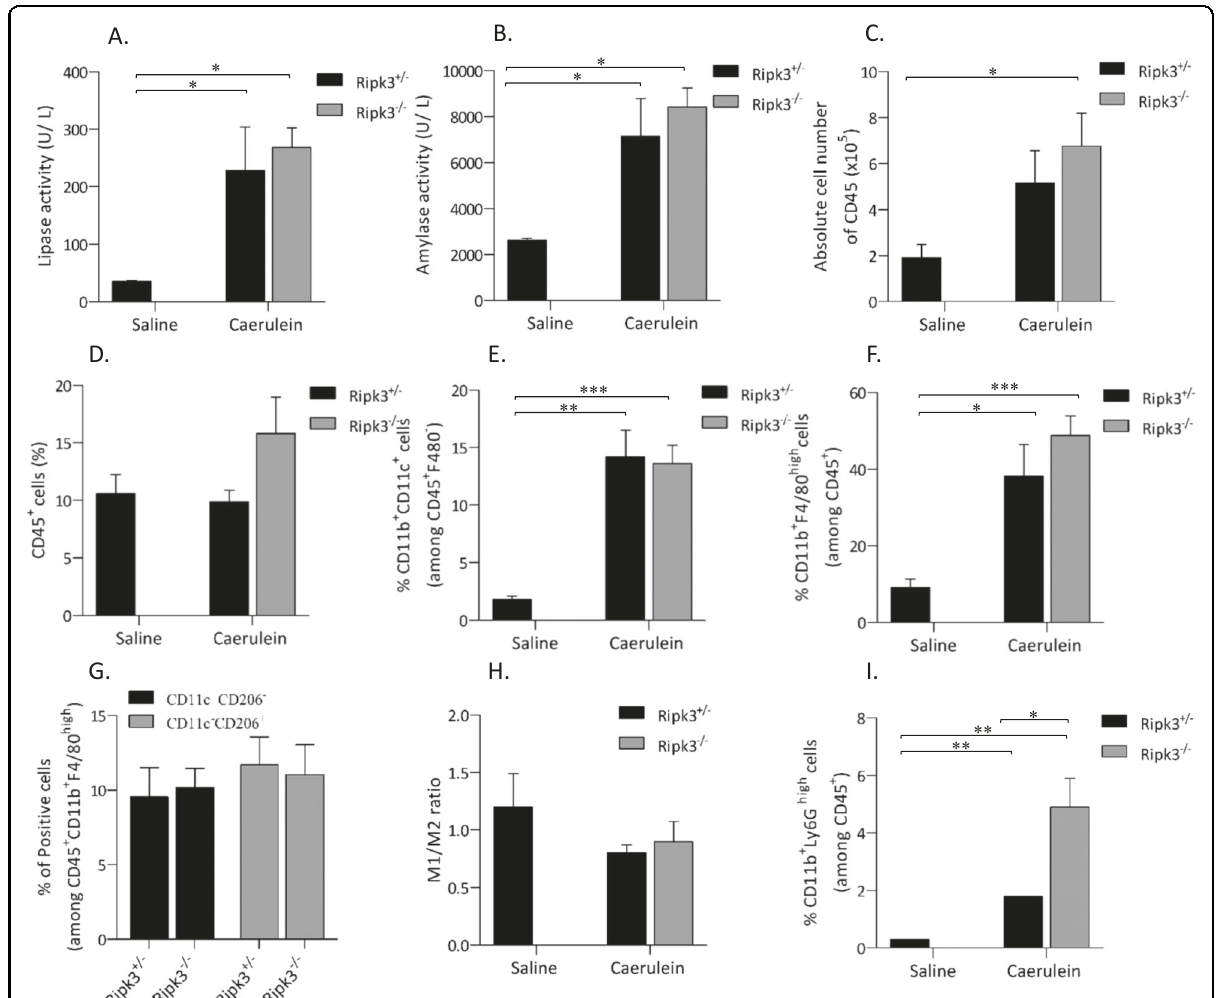
Fig. 6 The severity of AP in Ripk3 − / − mice was associated with neutrophil in fi ltration. Lipase ( A ) and amylase activity ( B ) were determined in serum collected at 12 h after the last injection of either PBS or caerulein. C Absolute CD45 + cell counts in freshly isolated pancreatic tissues from each group were determined by an automated cell counter. Flow cytometry analysis was performed to identify in fl ammatory immune cells in pancreatic tissue. Bar plots showing the percentage of CD45 + cells ( D ), the percentage of CD45 + F4/80 − CD11b + CD11c + dendritic cells ( E ), the percentage of CD45 + CD11b + F4/80 high macrophages ( F ), the percentages of CD11c + CD206 - M1-like macrophages and CD11c − CD206 + M2-like macrophages ( G ), the ratio of M1/M2 macrophages ( H ), and the percentage of CD45 + CD11b + Ly6G high neutrophils ( I ). The data are presented as the means ± SEMs. * P < 0.05, ** P < 0.01, and *** P < 0.001. These data are representative of three